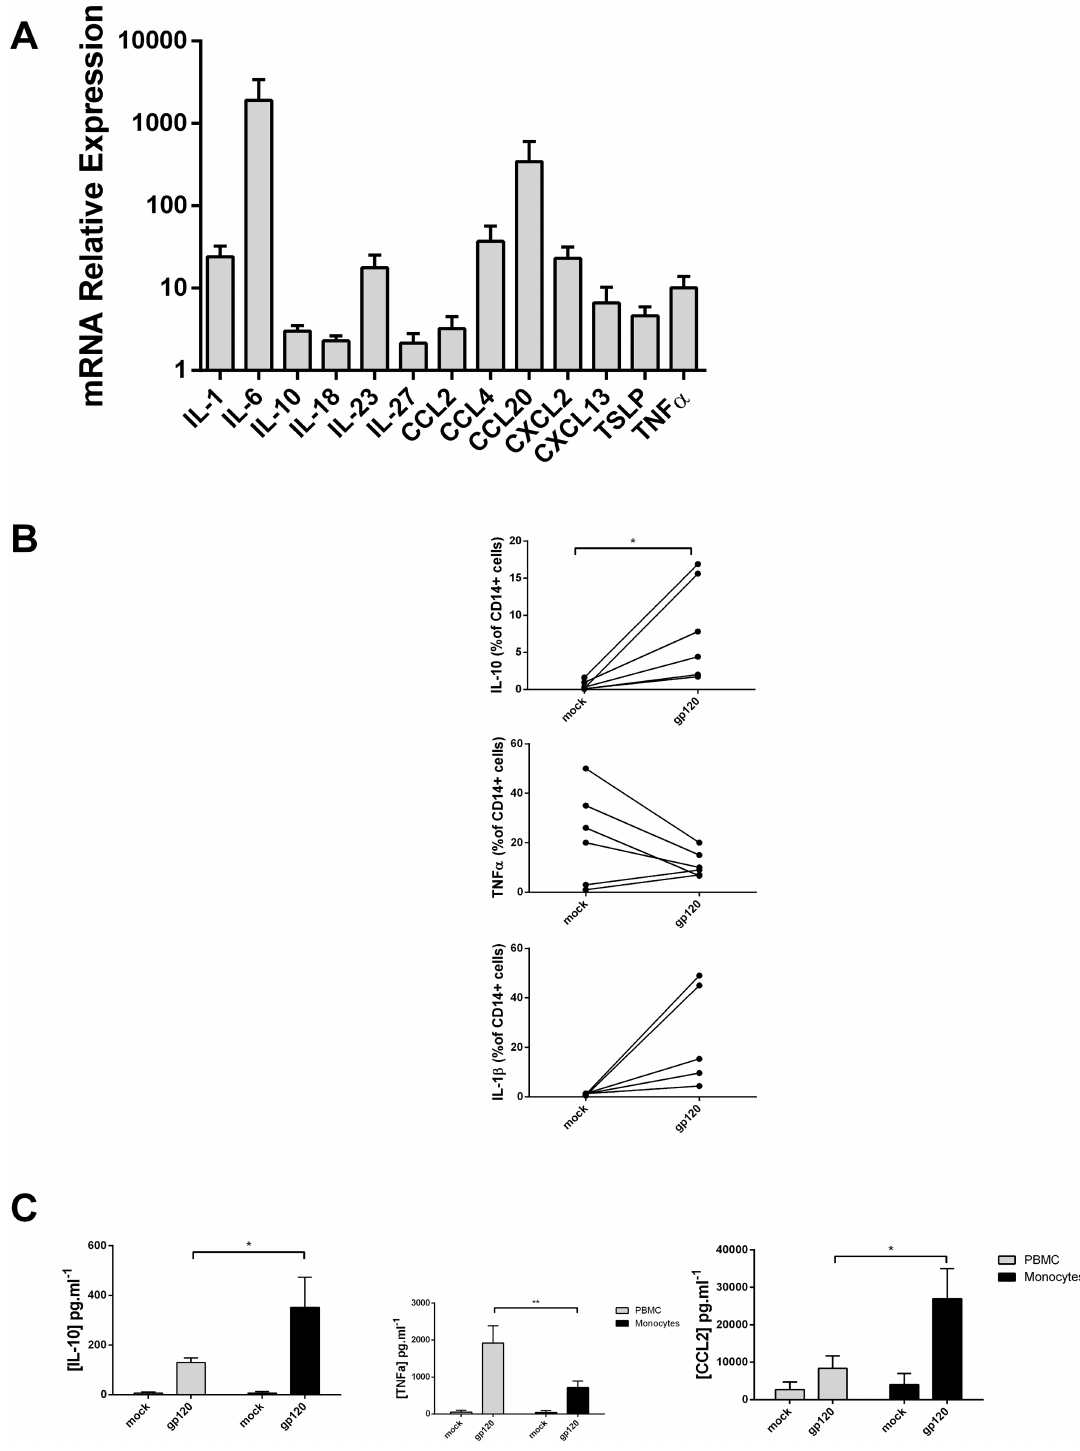
Fig 1. gp120 induces a cytokine burst in PBMC and monocytes. A) mRNA expressionof cytokines done by RT-qPCR, level of expressionafter stimulationwith gp120 is relativeto the mock control set at 1 for each cytokine. B) Flow cytometry analysisof PBMC CD14+ population, expressionof IL-10, TNF- α and IL1-ß are detected by intra-cellular staining (left panels). Data are representedin pairedsamplesand statistic analysisperformed with pairedt-test ( * p < 0.05).C) PBMC (grey bars) and monocytes (black bars) supernatant analysisby ELISA detectionof IL-10, TNF- α and CCL2after stimulationwith gp120. Statistic analysisperformed with t-tests present the difference betweenthe two cell type ( * p < 0.05and ** p < 0.01).